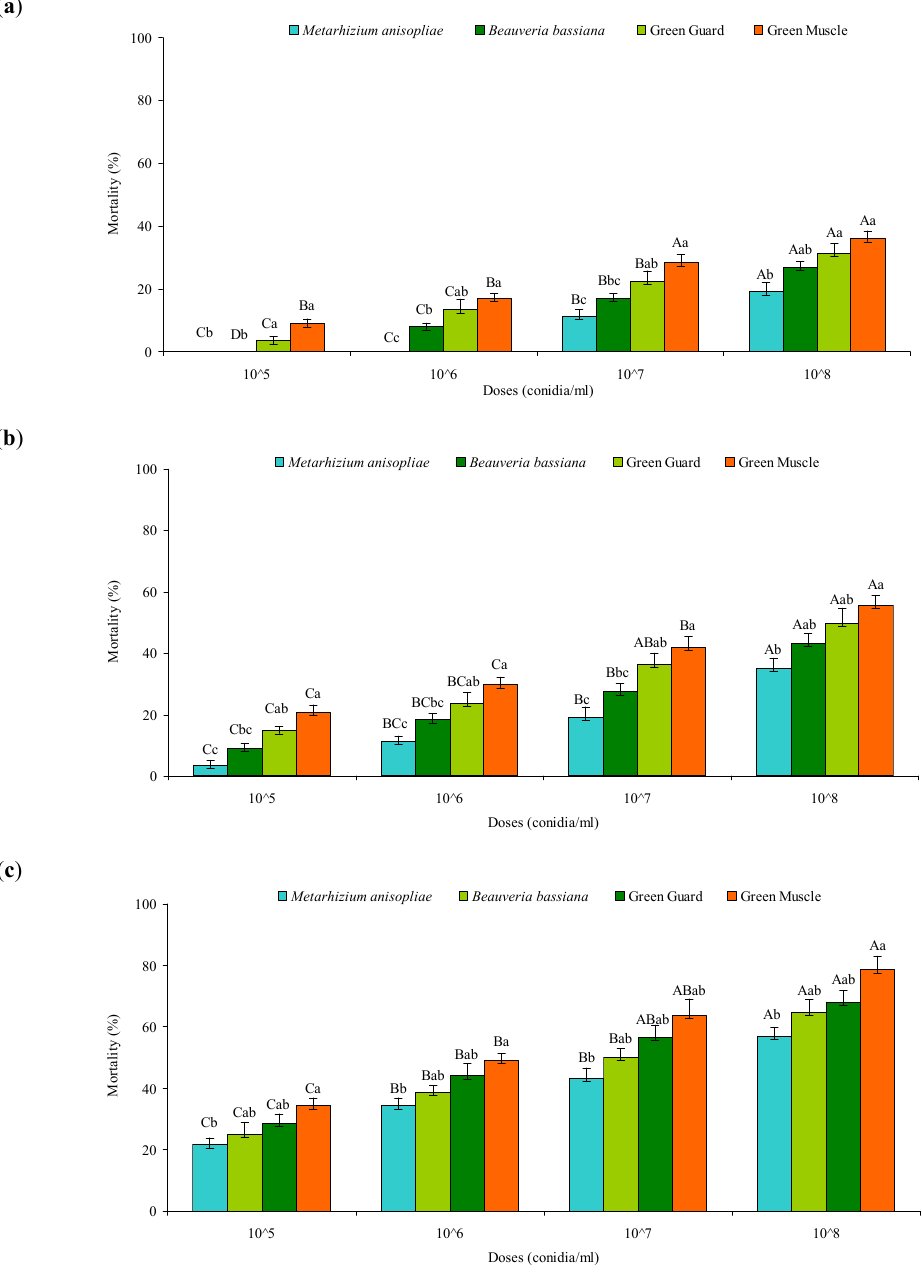
Figure 3. Mean mortality percentages ( ± SE) of S. gregaria adults after ( a ) 5 days, ( b ) 7 days, and ( c ) 12 days of treatment with various doses (10 5 , 10 6 , 10 7 , and 10 8 conidia/mL) of Green Muscle, Green Guard, B. bassiana , or M. anisopliae . Mortality data were corrected for control mortality, which was <5%. For each subfigure: different lowercase letters indicate significant differences in mortality between each of the EPF; different uppercase letters indicate significant differences in mortality between doses (Tukey’s HSD test at p ≤